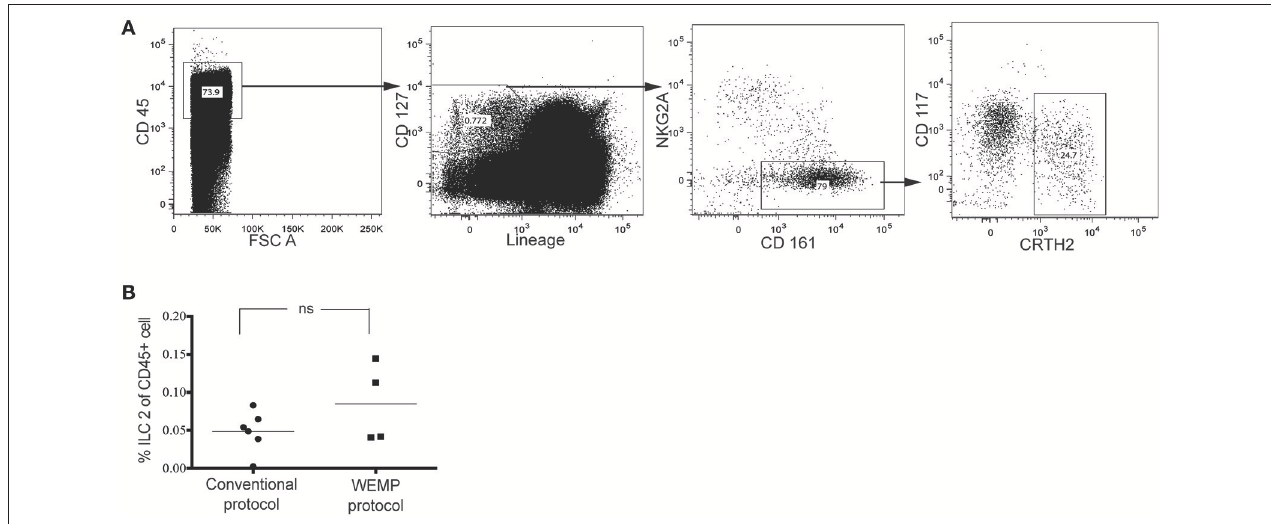
FIGURE 5 | Frequency of ILC2 from human lung tissue. (A) Single cell suspension from human lung tissue was stained with markers for lineage, CD45, CD127, CD161, NKG2A, and CRTH2. ILC2 were identified by flow cytometry analysis. (B) ILC2 yield was compared between conventional and WEMP protocol.